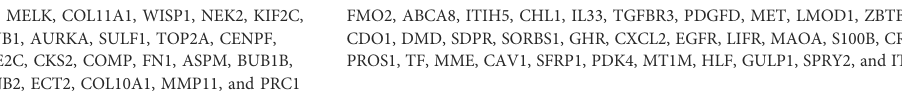
TABLE 2 List of up- and downregulated